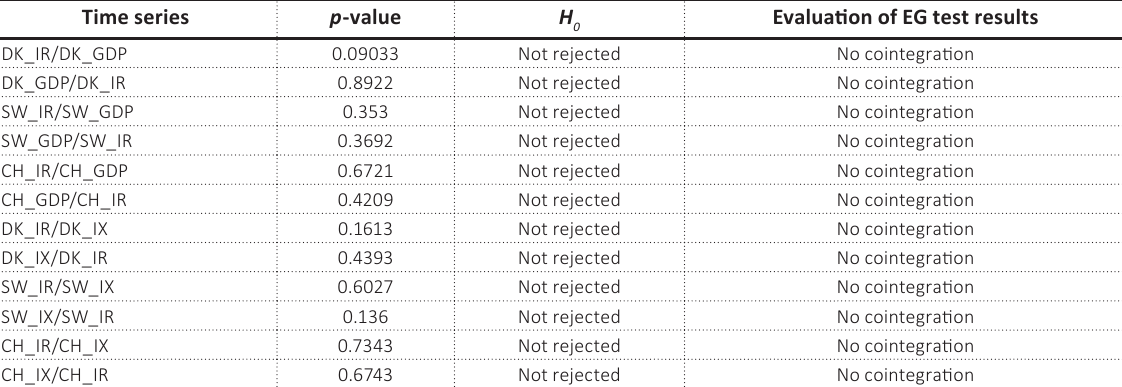
Table 8. The results of the Engle-Granger cointegration